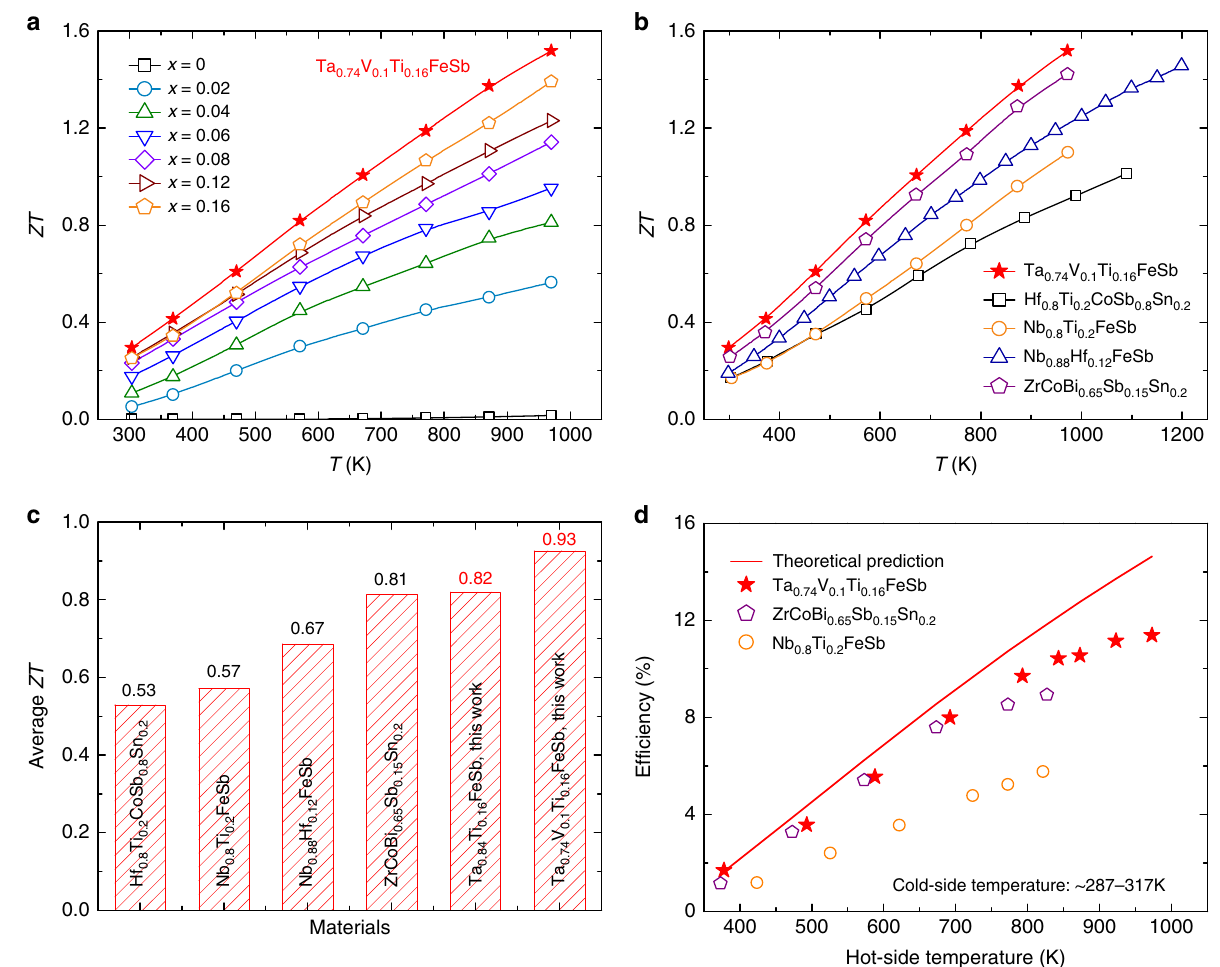
Fig. 5 Dimensionless thermoelectric fi gure of merit of TaFeSb-based half-Heuslers. a Temperature-dependent ZT of Ta 1- x Ti x FeSb, b comparison of the ZT between Ta 0.74 V 0.1 Ti 0.16 FeSb and the other state-of-the-art p-type half-Heuslers 24 – 27 , c comparison of the average ZT (in the range between 300 and 973 K) between TaFeSb-based half-Heuslers and the other state-of-the-art p-type half-Heuslers, and d the measured hot-side temperature-dependent heat-to- electricity conversion ef fi ciency of Ta 0.74 V 0.1 Ti 0.16 FeSb as compared with state-of-the-art p-type half-Heuslers ZrCoBi 0.65 Sb 0.15 Sn 0.2 40 and Nb 0.8 Ti 0.2 FeSb 25 . The cold-side temperature is fi xed at 300 K for the calculation of ef fi ciency (solid line)